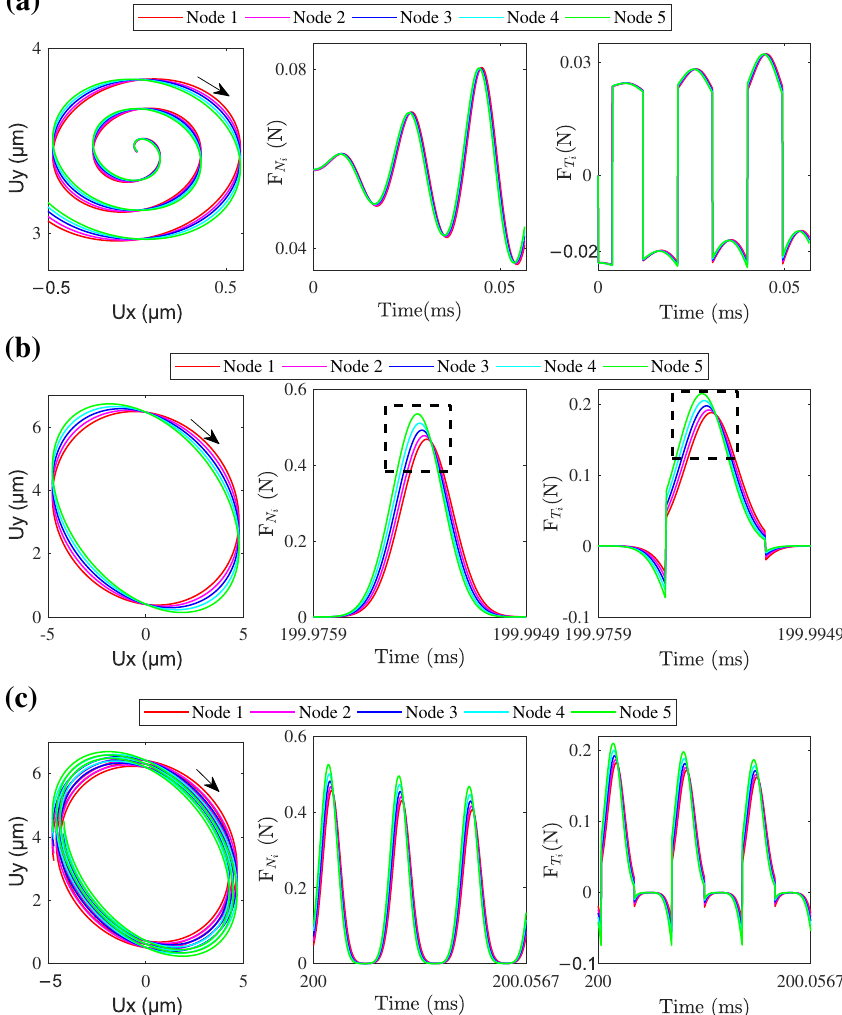
Figure 25. Simulated trajectories and contact forces for 5 nodes at the contact surface: ( a ) first three circles in the ON transient state, ( b ) one circle in steady state, and ( c ) first three circles in the OFF transient